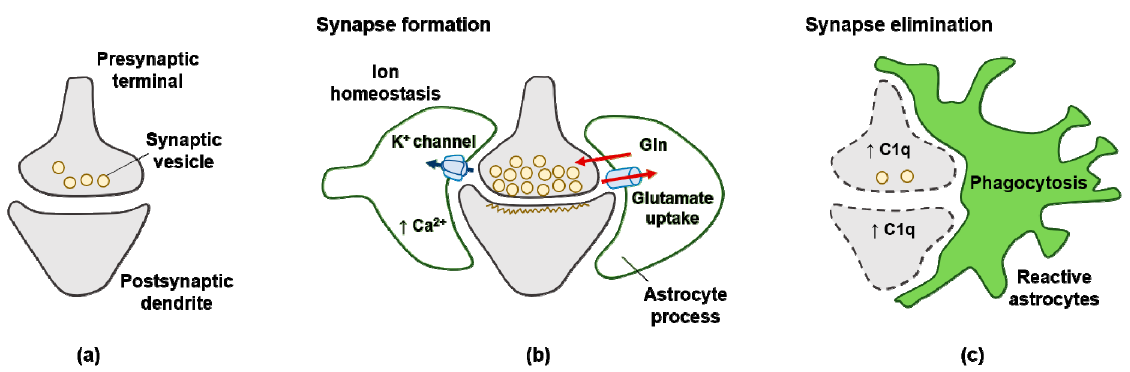
Figure 2. Signals from astrocytes promote synapse formation and elimination: ( a ) neurons without astrocytes form less synaptic neurotransmitter vesicle; ( b ) astrocytes promote the maturation of both pre- and postsynaptic elements of the synapse; ( c ) reactive astrocytes upregulate expression of the complement component C1q in neurons, leading to elimination by astrocyte-mediated phagocytosis.